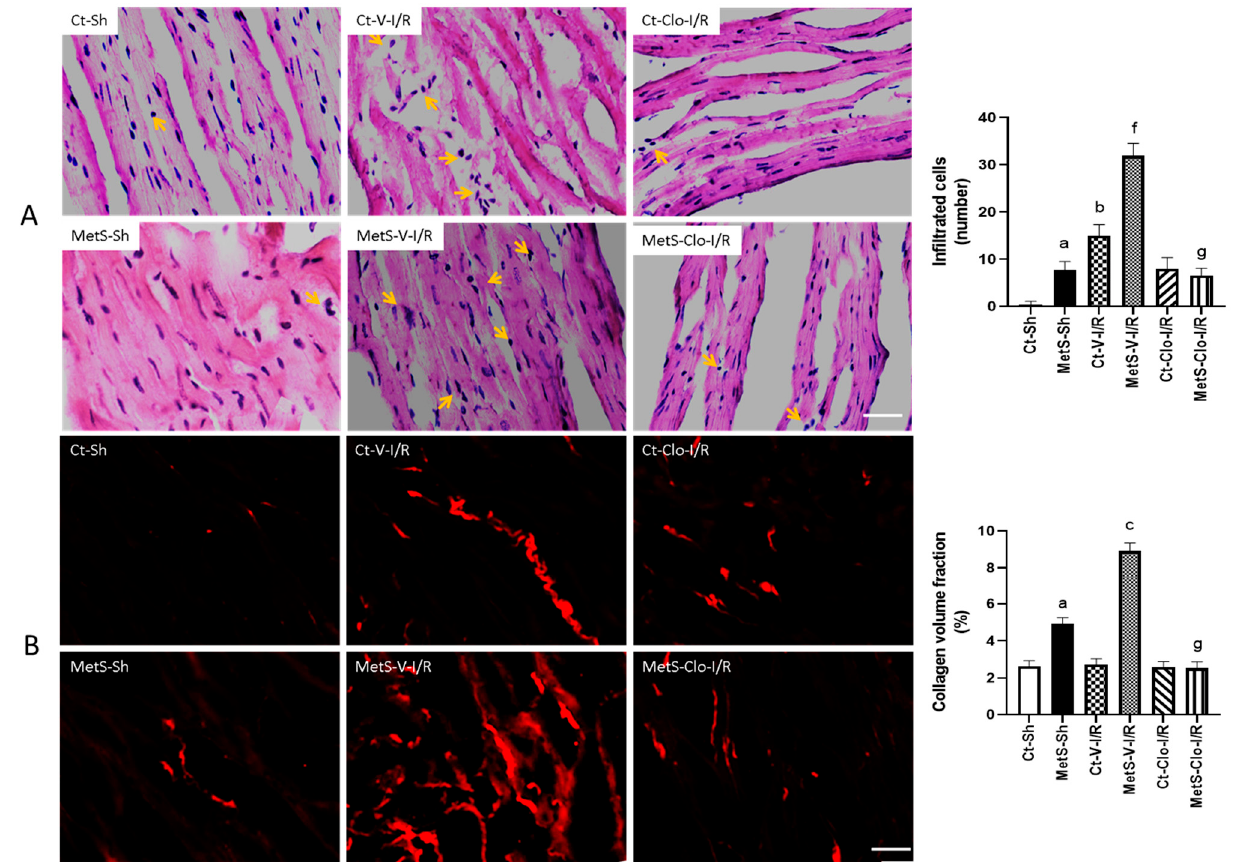
Figure 2. Effect of treatment with clofibrate on infiltrated cells and collagen volume fraction (CVF) in hearts with ischemic/reperfusion (I/R) damage. In ( A ), the sites where cellular infiltrates are located are indicated with arrows in images stained with hematoxylin–eosin (HE). In ( B ), the fluorescence areas with collagen deposits are distinguished in red with picrosirius red (PSR) staining. Representative images of histological examinations are presented and the mean ± SEM values of the number of infiltrated cells and the mean ± SEM of CVF % are shown in the graphs. a p < 0.0001 vs. Ct-Sh; b p < 0.0001 vs. Ct-Sh; c p < 0.0001 vs. Ct-V-I/R; f p < 0.0001 vs. MetS-Sh; g p < 0.0001 vs. MetS-V-I/R. Abbreviations: Ct = control; MetS = metabolic syndrome; Sh = sham-operated rats; V = vehicle; Clo = clofibrate. Bar = 100 µ